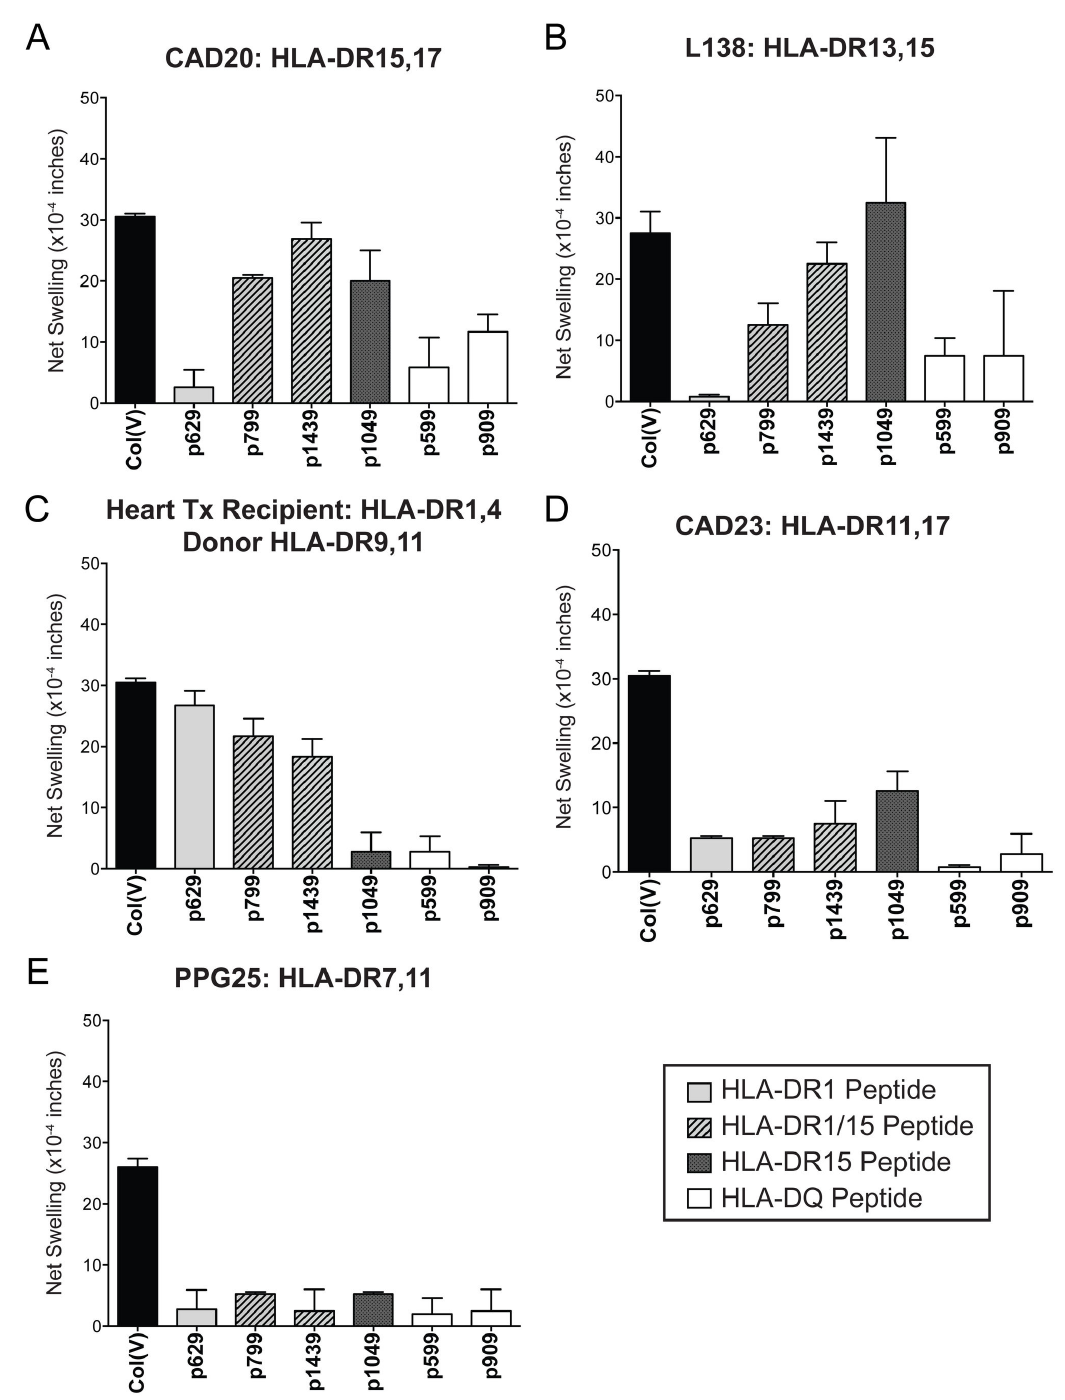
Figure 5. Candidate α1(V) peptide screen in col(V)-responsive patients. PBMC from (A) CAD patient 20 (HLA-DR15, 17; - DQ2,6), (B) End-stage lung disease patient L138 (HLA-DR13,15; -DQ5,6) (C) Heart transplant recipient H76 (HLA-DR1,4; -DQ3,5, with donor HLA-DR9,11; -DQ3,-), (D) CAD patient 23 (HLA-DR11,17; -DQ2,7) and (E) End-stage lung disease patient PPG25 (HLA- DR7,11; -DQ2,7) were screened for reactivity to ProImmune binding peptides by TV-DTH. Results from HYP and non-HYP p629, p599 were combined. Patient response to intact col(V) (black bar), HLA-DR1-specific peptide (light gray bar), HLA-DR1/15-specific peptides (hatched bars), HLA-DR15-specific peptide (dark gray bar), and HLA-DQ/H-2 I-A b binding peptides (white bars) are shown. (Data represents the mean of 2-4 separate assays). doi: 10.1371/journal.pone.0079601.g005 PLOS ONE |